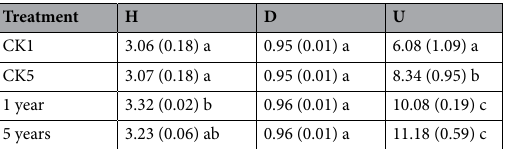
Table 2. Functional diversity (i.e. Shannon (H), Simpson (D), and McIntosh (U)) indices of the soil microbial community in reconstructed mine substrates (RMS). Parentheses show standard deviations. Different small letters indicate significant differences among different reclaimed soil treatments at a significance level of p <